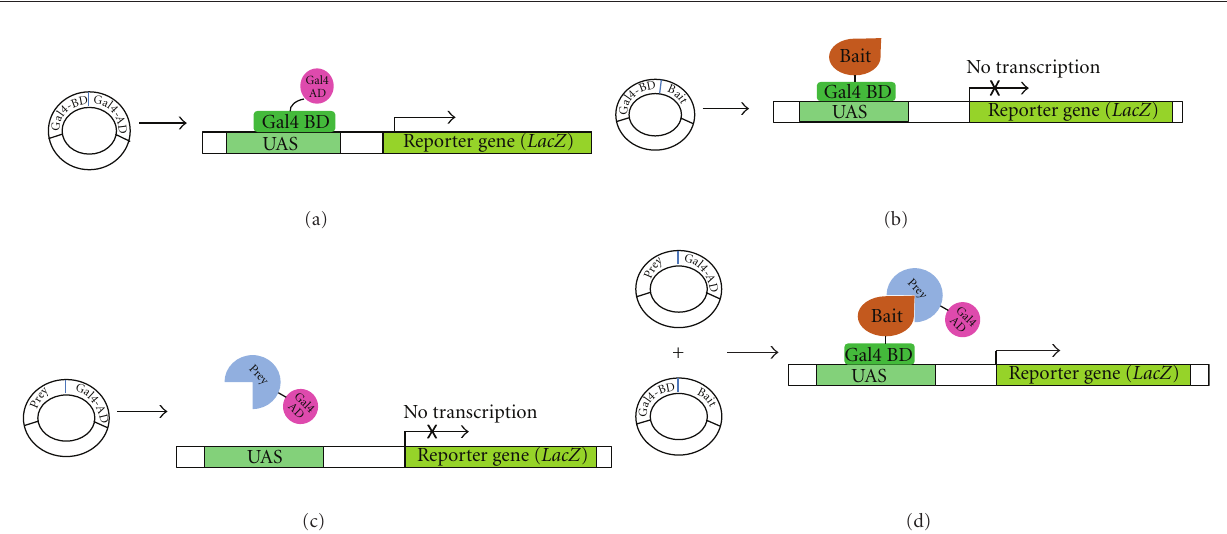
Figure 1: The two-hybrid assay, checking for interactions between two proteins, here called Bait and Prey. (a) Gal4 transcription factor gene produces two domain proteins (BD and AD), which are essential for transcription of the reporter gene (LacZ). (b) and (c), Two fusion proteins are prepared: Gal4BD +Bait and Gal4AD +Prey. None of them is usually su ffi cient to initiate the transcription (of the reporter gene) alone. (d) When both fusion proteins are produced and the Bait part of the first interacts with Prey part of the second, transcription of the reporter gene occurs (adapted from